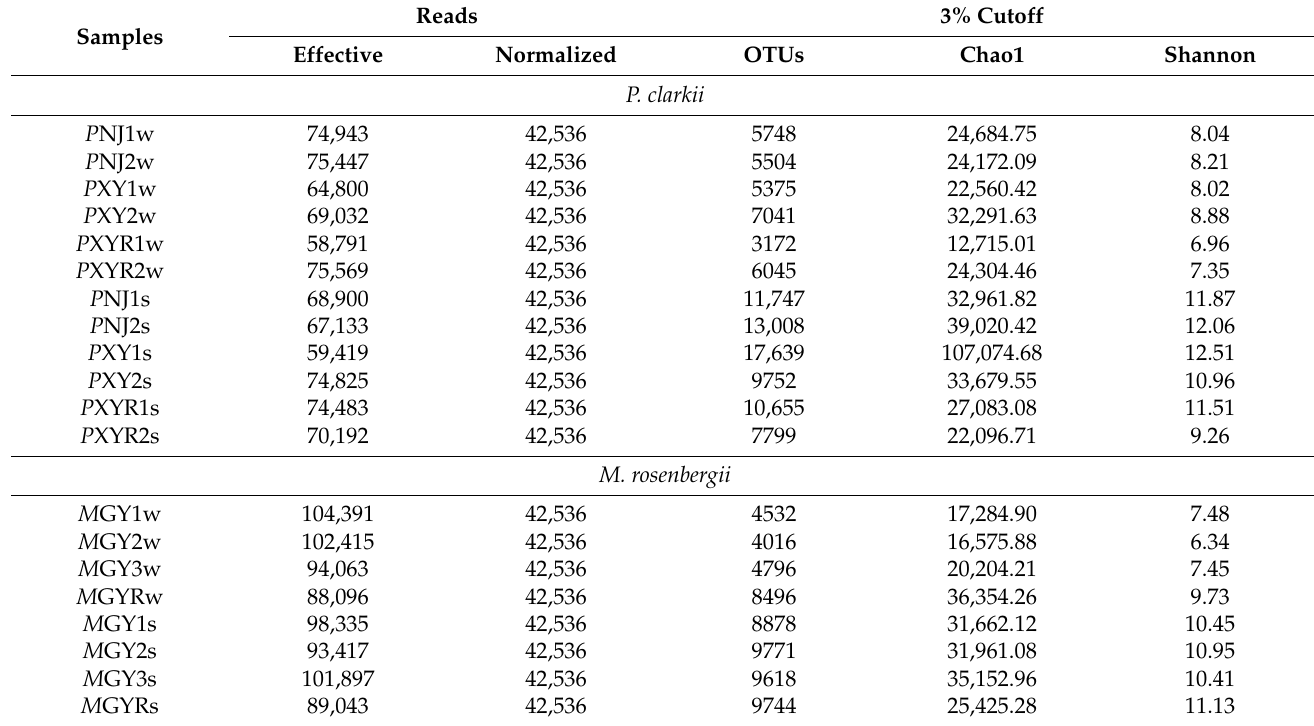
Table 2. Reads and α -diversity information of the water and sediment samples in two types of shrimp ponds and downstream sections of the